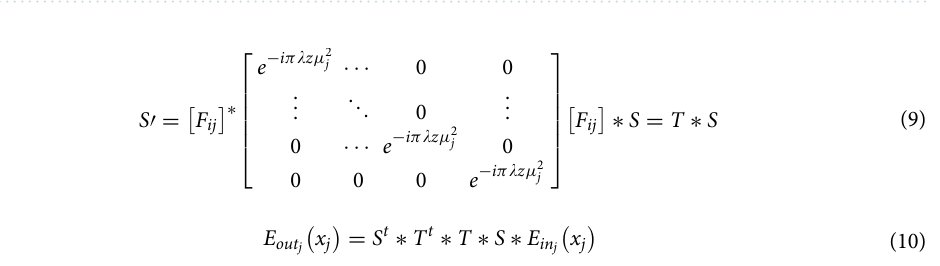
Figure 10. ( a ) This shows that there exists an ideal-shaped wavefront that produces a focused spot behind the thick media. ( b ) The illustration shows that the focused light passes through the same scattering medium in a backward scattering direction. The output wavefront is measured will be the conjugate of the ideal shaped wavefront. This would be the condition to obtain focus after the first pass through the